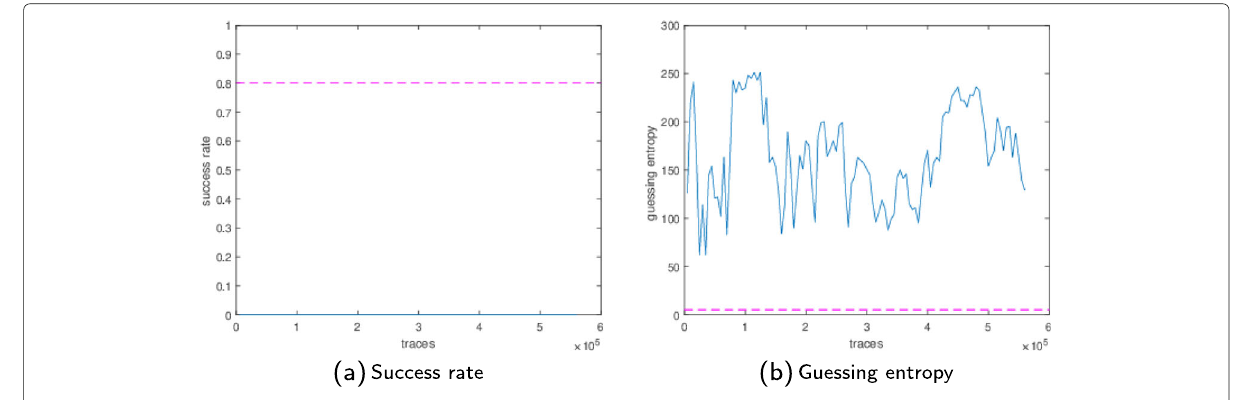
Fig. 10 First-order attacks on hardware RSMv2 implementation after combining our